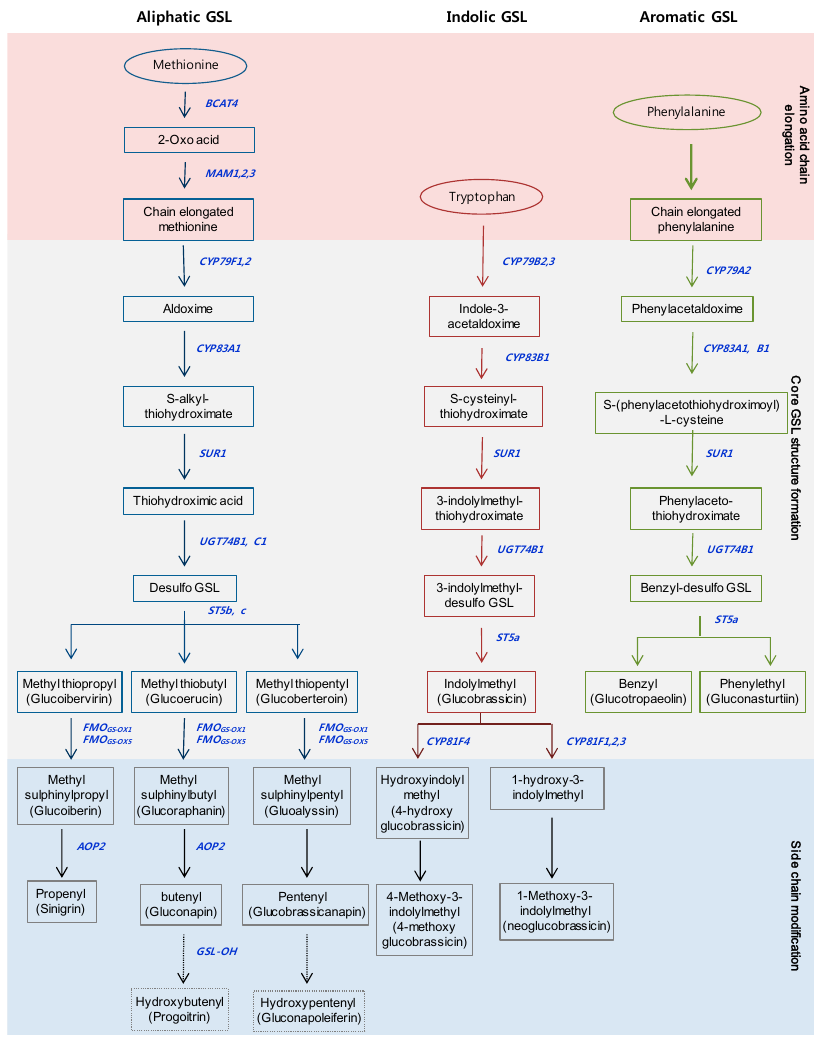
Figure 1. Three major biosynthesis pathways of the glucosinolates in Brassicaceae. Outline of the pathways which can be divided into three parts; (1) amino acid chain elongation; (2) formation of the core structure of GSLs; (3) side chain modification. Blue bold indicates biosynthetic genes involved in each step. The names in parentheses denote common names.